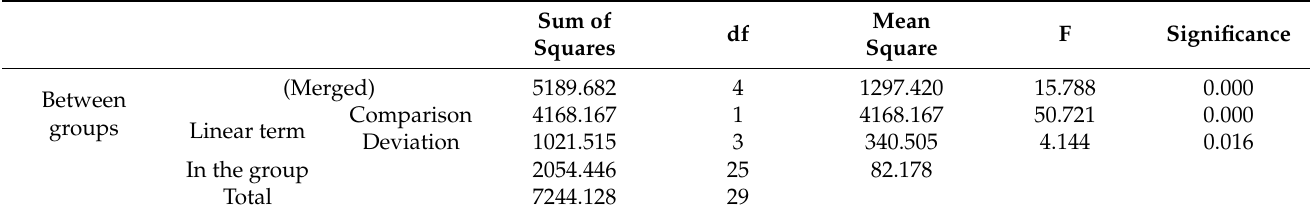
Table 8. Analysis of the variation number when the amount of fertilizer discharged is 0.29 kg/s. Mean Sum of df Square Squares